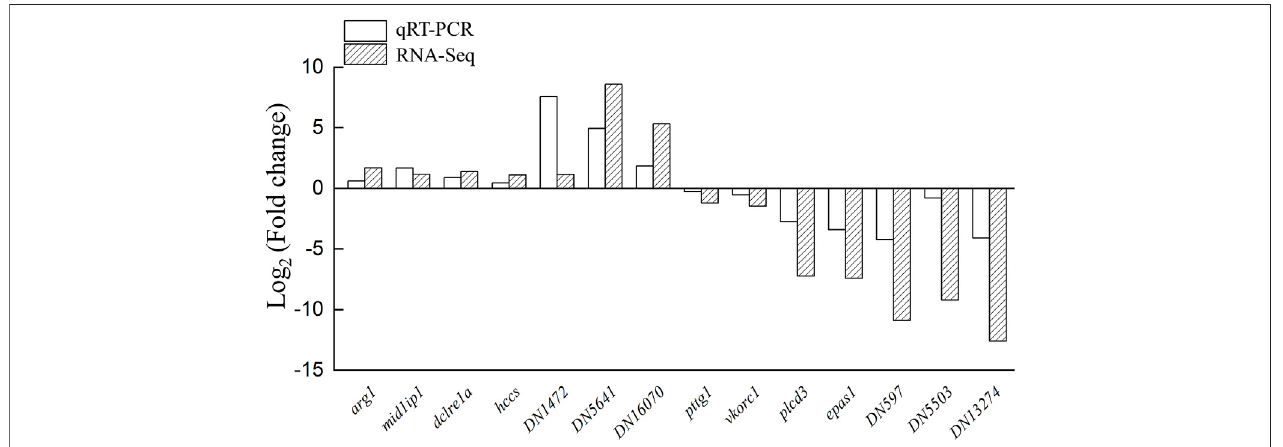
FIGURE 8 | Validation of transcriptomic data by qPCR. The 14 DEGs (differentially expressed genes) were selected randomly to detect the expression pro fi les. Some genes were not matched in any databases, and we named these genes DN1472, DN5641, DN16070, DN597, DN5503, and DN13274. The qPCR results were consistent with the transcriptomic data. y-Axis indicates Log 2 (Gene expression pro fi le of testis-removed fi sh/Gene expression pro fi le of control fi sh).